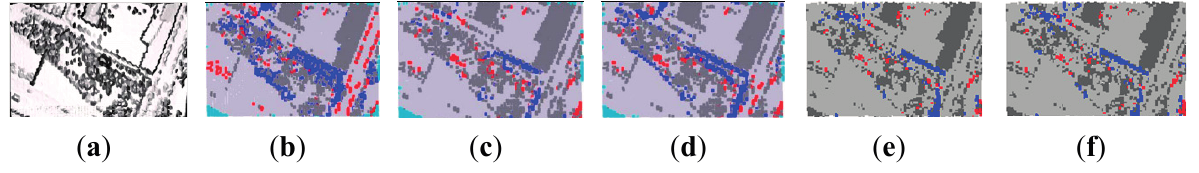
Figure 14. Comparison of the filtering results of different methods for sample 24: ( a ) DSM generated from the raw point clouds; ( b ) Sohn; ( c ) Axelsson; ( d ) Pfeifer; ( e ) Li et al. [38]; ( f ) This